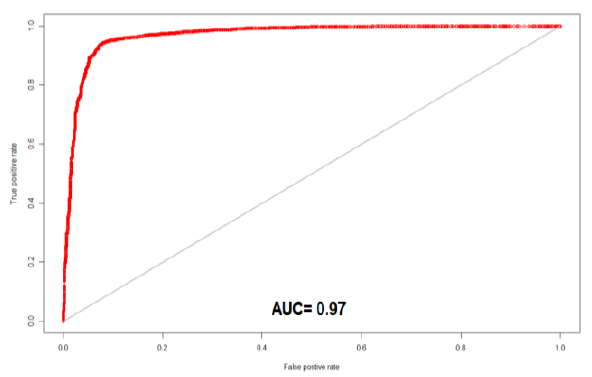
Figure 4. AUC plot against test data of first set